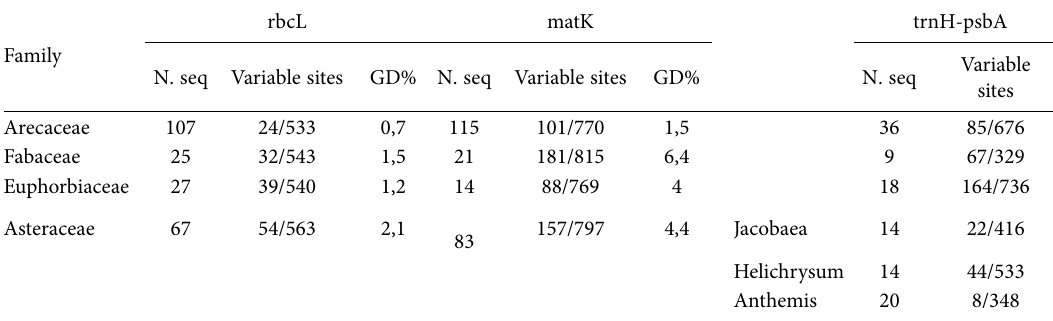
Table 4. Levels of genetic divergence for larger families. Genetic divergences calculated with the parameter K2P% (Kimura 1980). rbcL matK trnH-psbA Family N. seq Variable sites Arecaceae